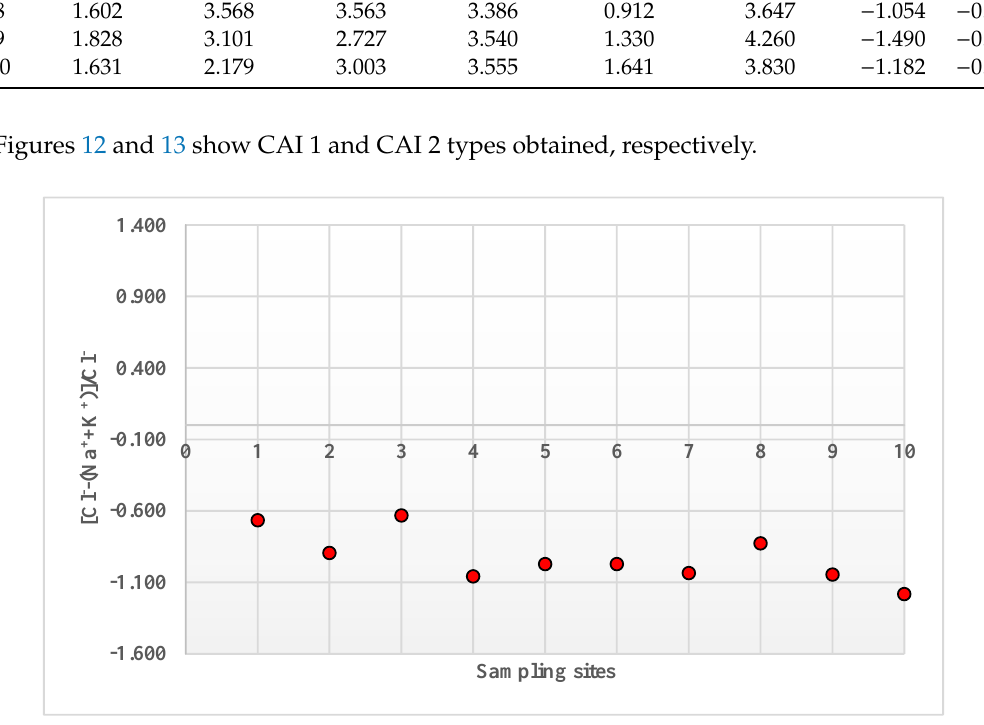
Figure 13. Chloro Alkaline Index type 2 (CAI 2) to determine the type of ion exchange occurred in the studied area. 3.7. Water Quality Index The weighted arithmetic average method was used in these calculations. This method for calculating the WQI considers the maximum permissible limits for any regulations, whether national [13] or international [44], and can be adapted to the needs of the type of study being carried out. However, it has certain limitations, such as that it is not possible to evaluate all the risks present in the water, and the weighting required for each parameter according to its importance could become subjective.